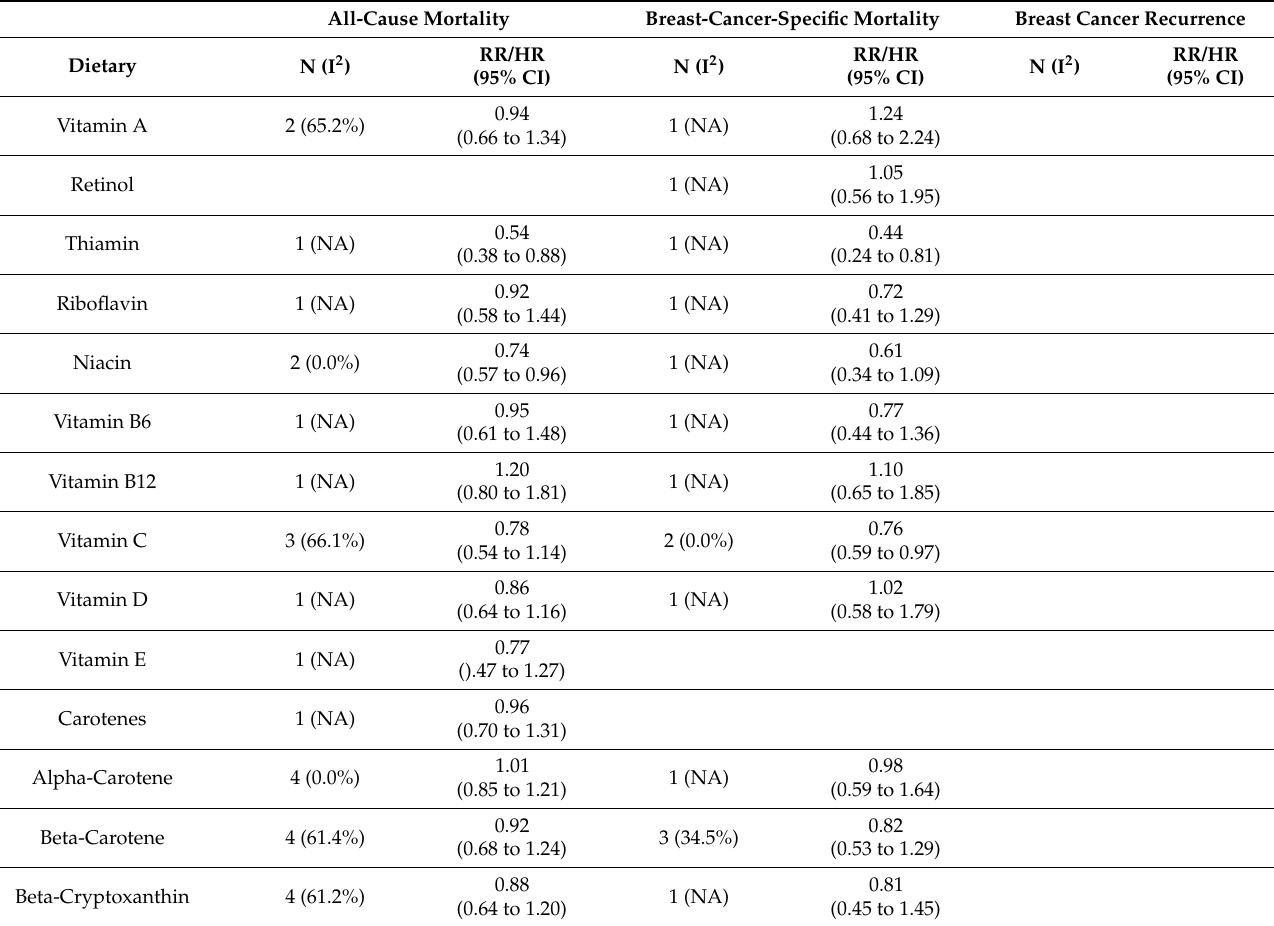
Table 3. Systematic review and meta-analysis of associations between dietary or supplementary micronutrient intake and breast cancer prognosis among breast cancer survivors. Breast-Cancer-Specific Mortality Breast Cancer